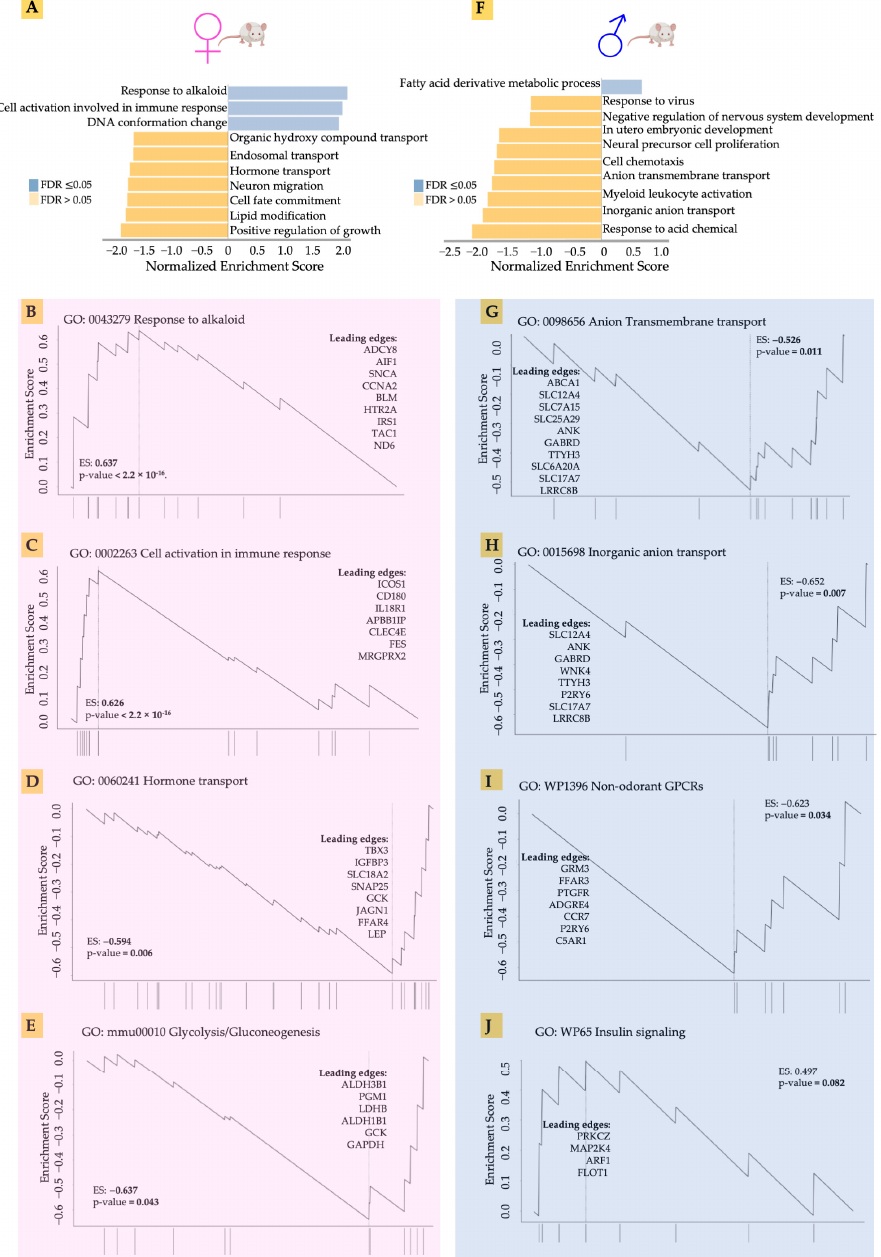
Figure 3. ( A , F ) The top enriched gene ontologies were very different between male and female samples, acccording to non-parametric Gene Set Enrichment Analysis (GSEA). ( B – E ) GSEA